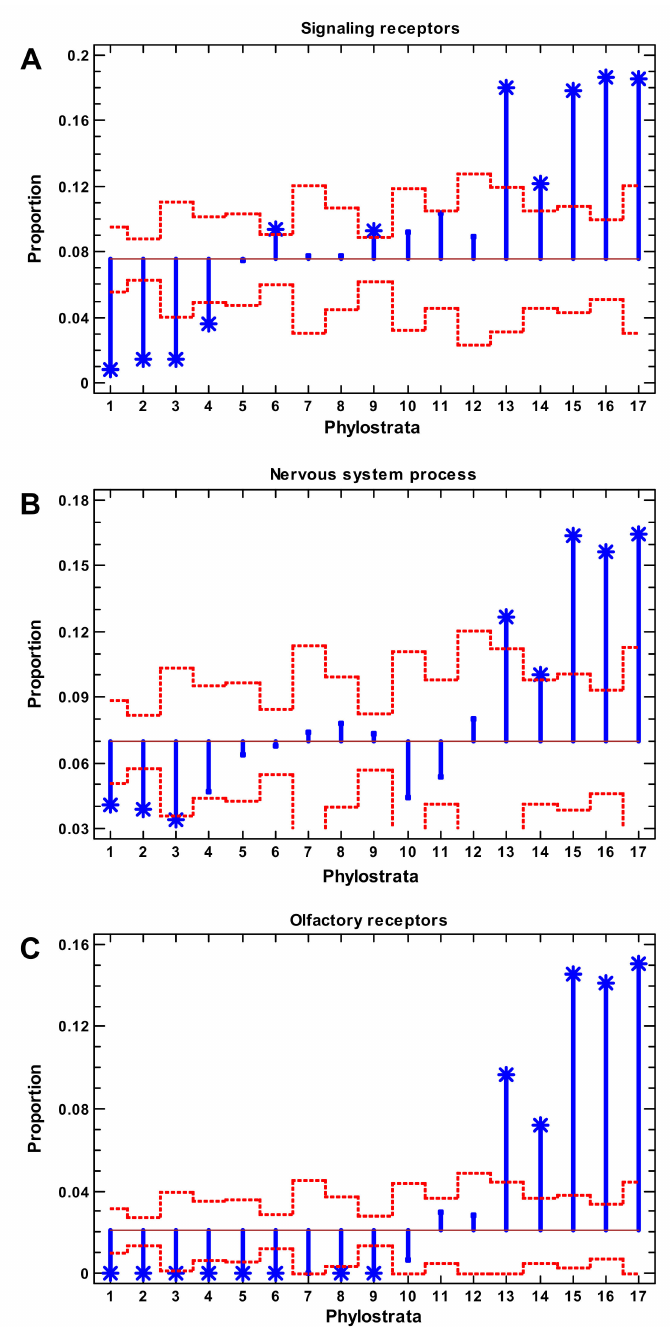
Figure 2. Gene proportion analysis of signaling receptors ( A ), nervous system process genes ( B ), and olfactory receptors ( C ). Red dotted lines show significance level ( p < 0.05), asterisks show significant enrichment (if above baseline) or underrepresentation (below baseline). (1—cellular organisms; 2—Eukaryota; 3—Opisthokonta; 4—Metazoa; 5—Eumetazoa; 6—Bilateria; 7—Chordata; 8—Vertebrata; 9—Euteleostomi; 10—Tetrapoda; 11—Amniota; 12—Mammalia; 13—Theria; 14— Eutheria; 15—Boreoeutheria; 16—Primates;